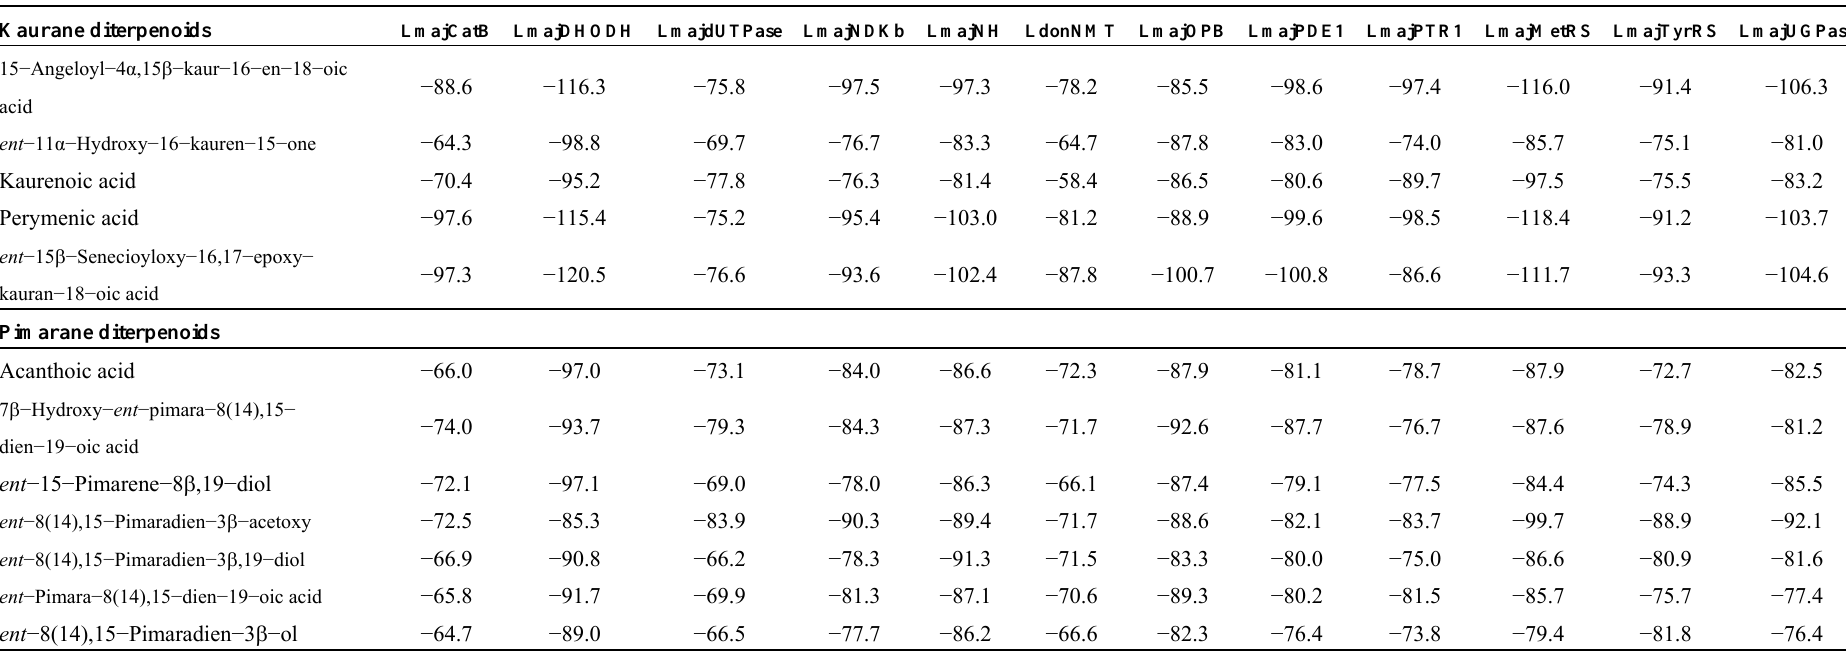
Table 24. MolDock docking energies (kJ/mol) of kaurane and pimarane diterpenoids with Leishmania major protein targets. Kaurane